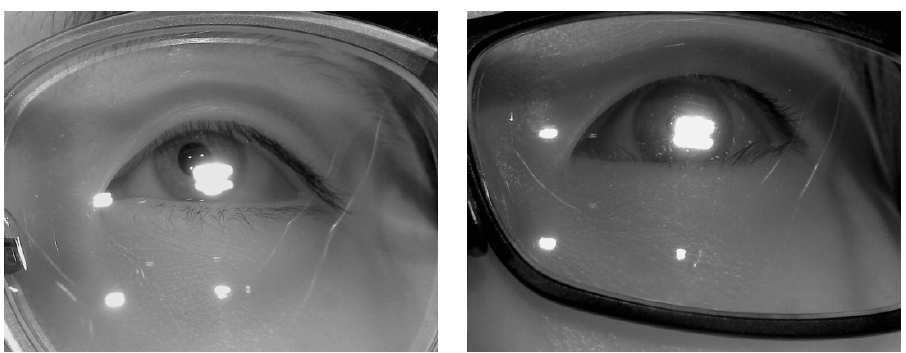
Figure 4. Examples of eye images where the reflections hide the pupil or the corneal